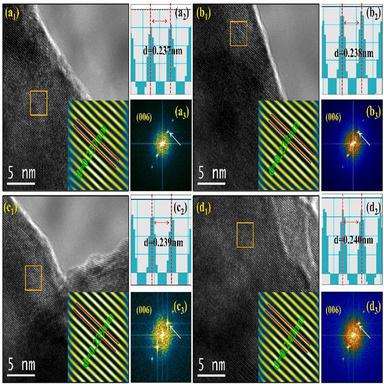
HRTEM (enlarged illustration obtained by inverse FFT), the relative line intensity profile and FFT images for (a1, a2, a3) bare NCM, (b1, b2, b3) M3-NCM, (c1, c2, c3) Z2-NCM, and (d1, d2, d3) MZ-NCM.